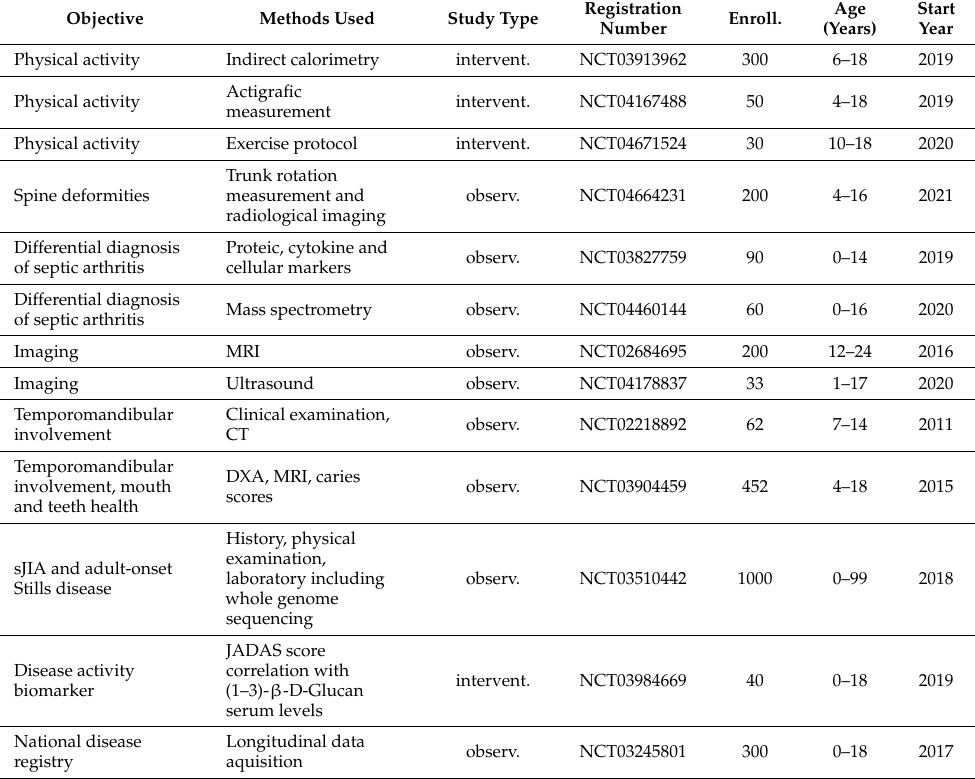
Table 3. Registered studies on diagnostics and measurement of disease